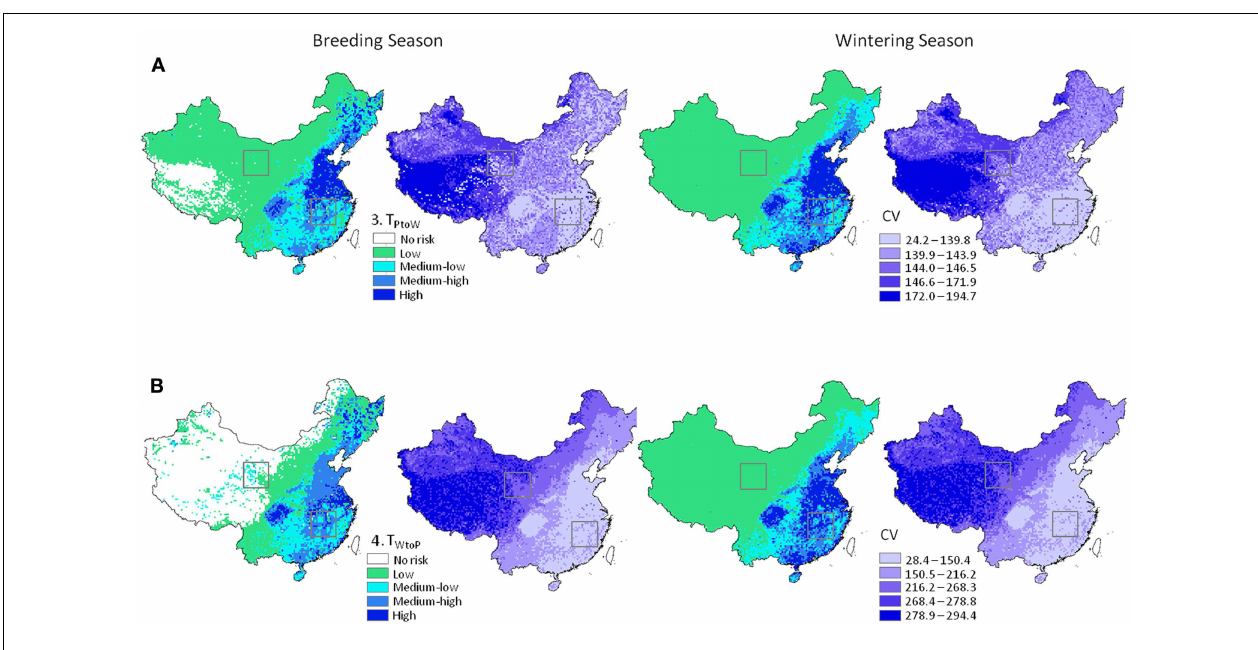
poultry to wild waterfowl; (B) bottom panel represents transmission risk from wild waterfowl to poultry. Maps are symbolized using quantiles. Black boxes correspond to the Qinghai Lake and Poyang Lake Regions outlined in Figure 5 .